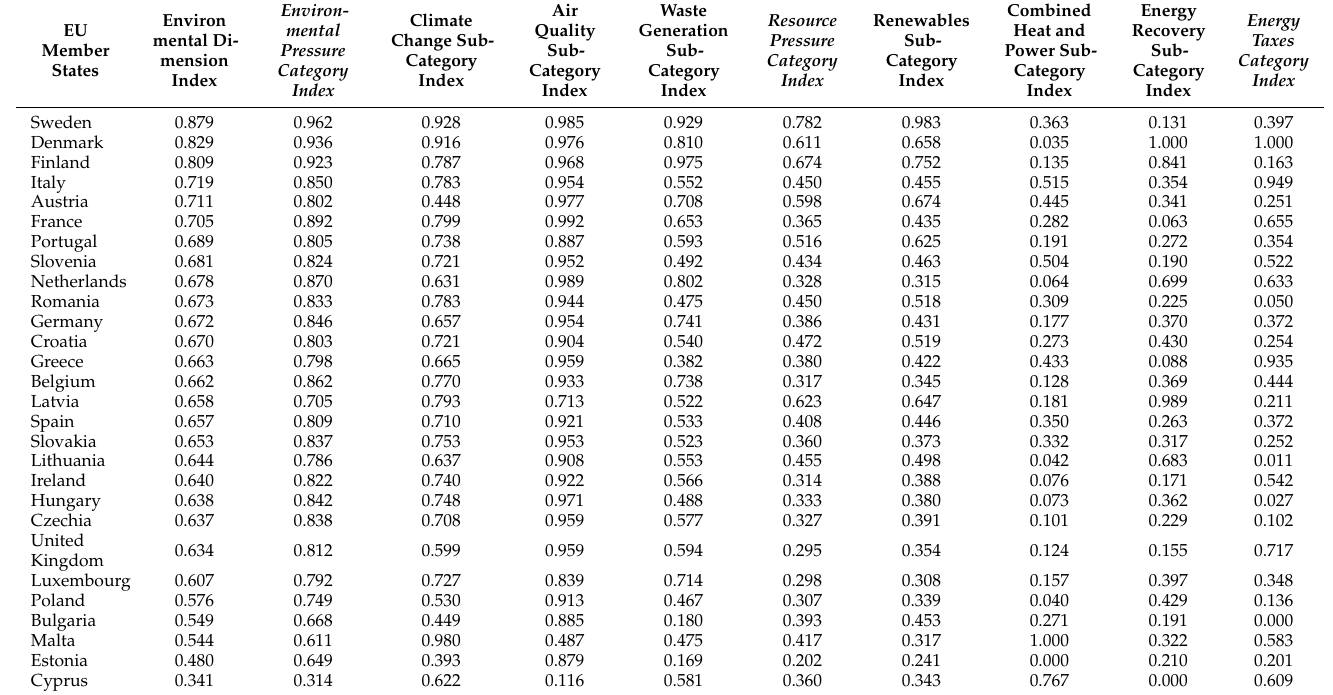
Table 5. Results in environmental dimension partial